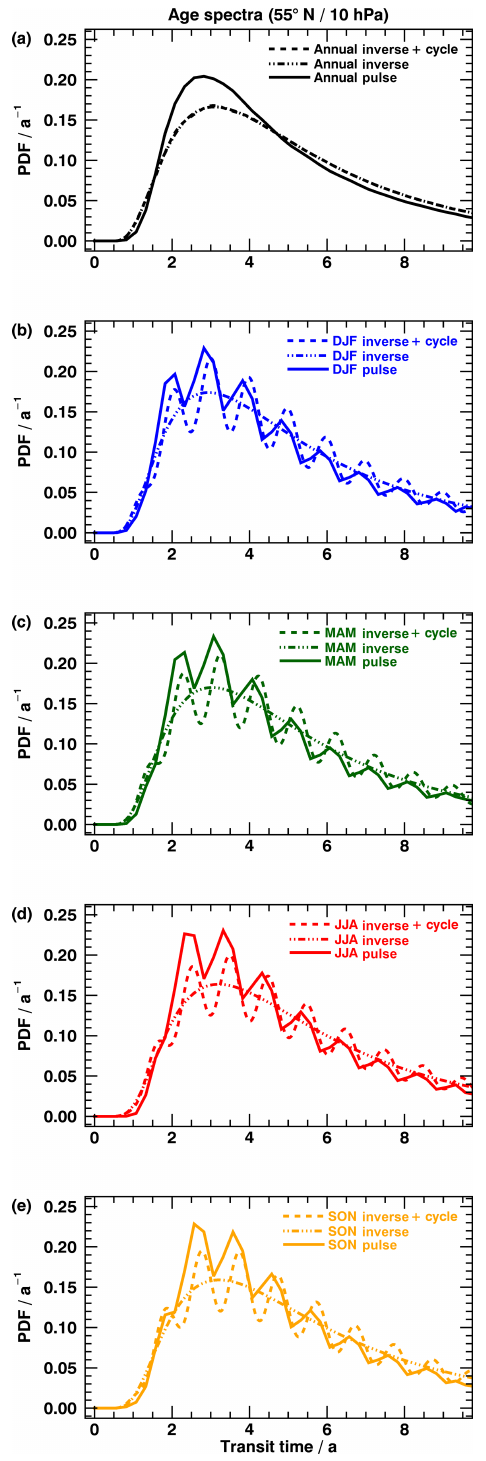
Figure 5. Same as Fig. 4, but at 55 ◦ N and